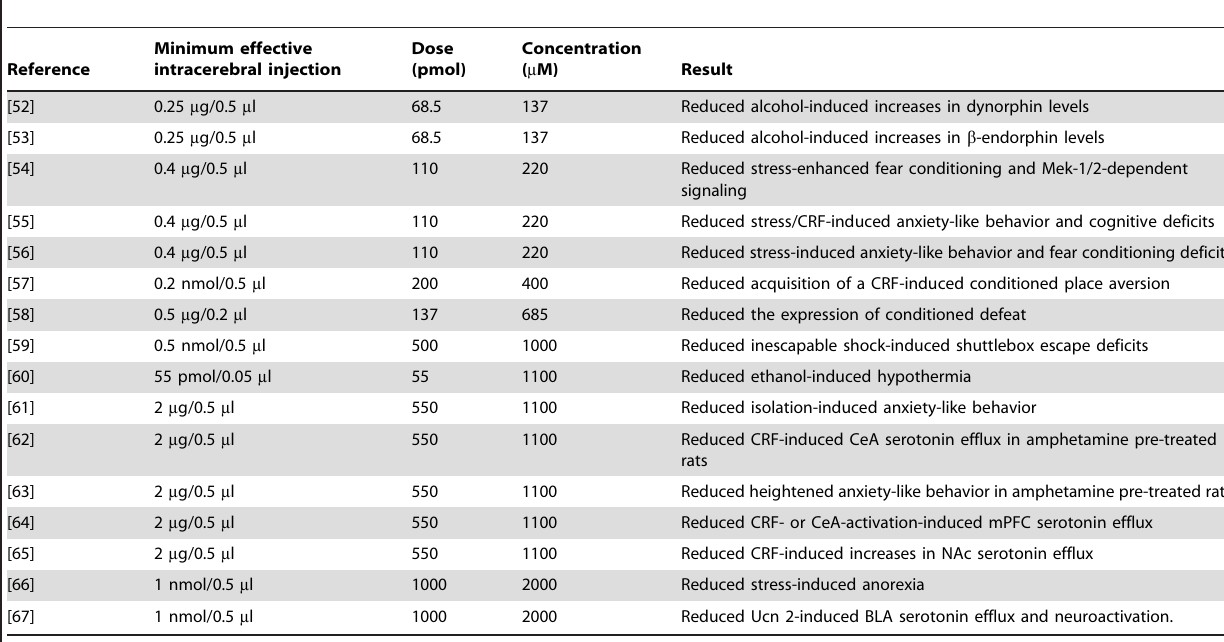
Table 3. Intracerebral (IC) site-specific studies of antisauvagine-30 effects on stress- or anxiety-related endpoints.